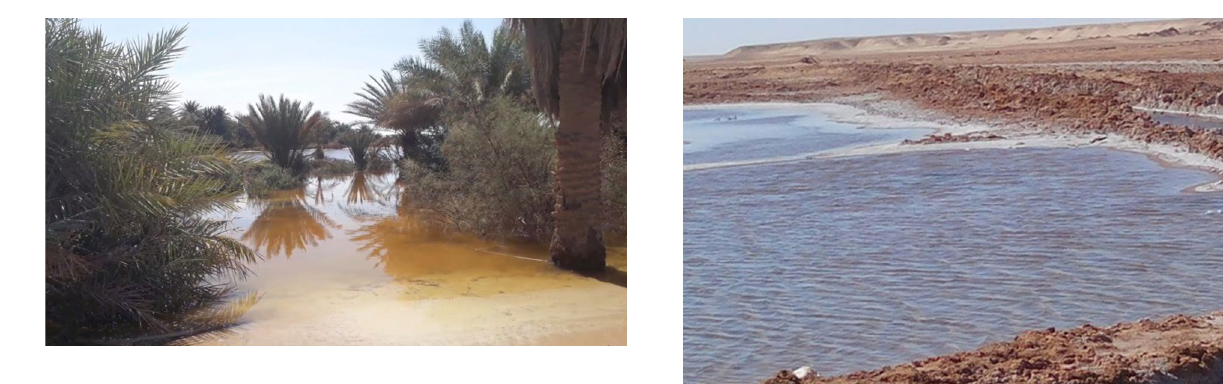
Fig. 20 Flooding of Igmou palm groves. (photo. Authors 2018)